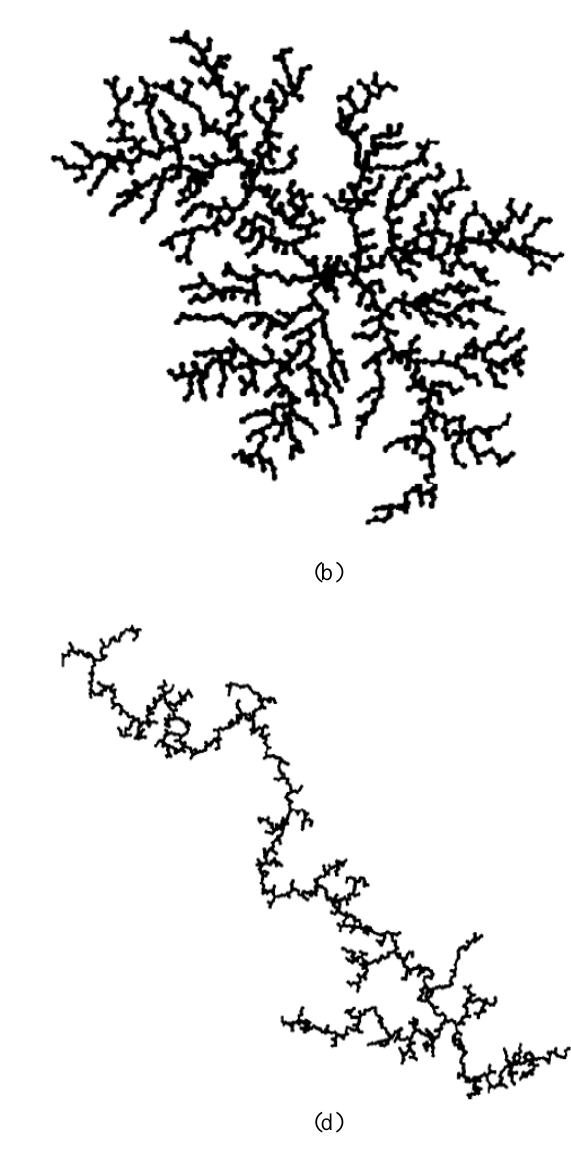
Fig. 2. Beginning . Computer models of formation of casein clusters: (a) DLA, (b) BLA, (c) RLA, (d) DLCA, (e) RLCA, and (f)